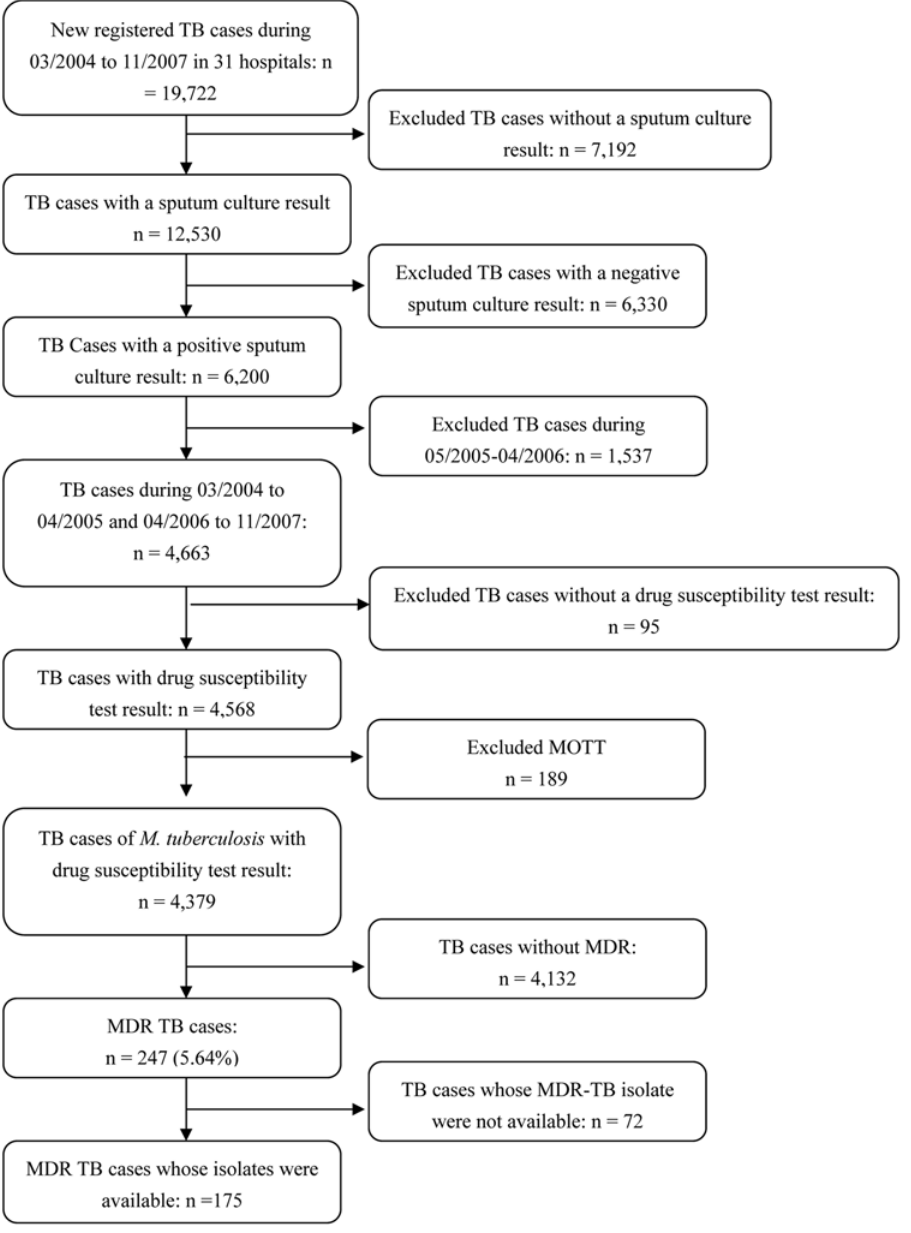
Figure 1. Study population of cases of drug resistant tuberculosis in Shanghai, March, 2004–November, 2007. TB=tuberculosis. MDR=multidrug-resistant. MOTT=Mycobacteria other than tuberculosis.